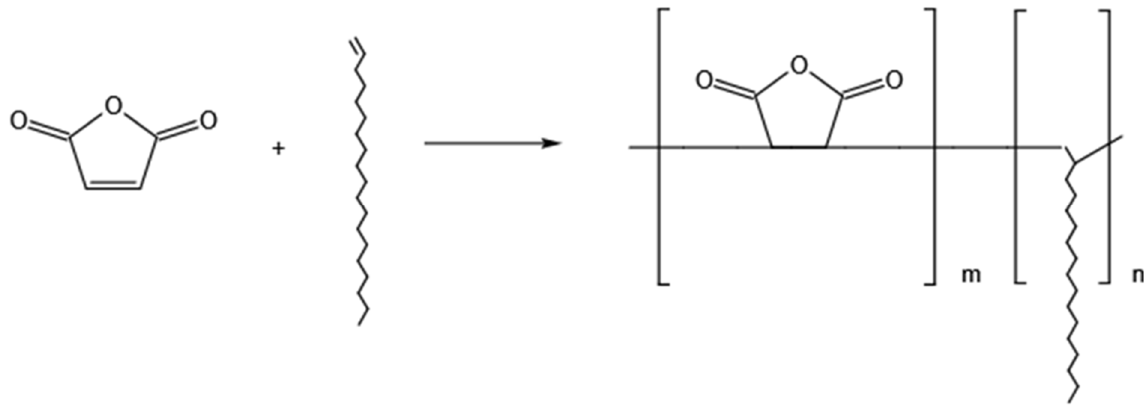
Figure 2. Synthesis of the maleic anhydride- α -octadecene copolymer.